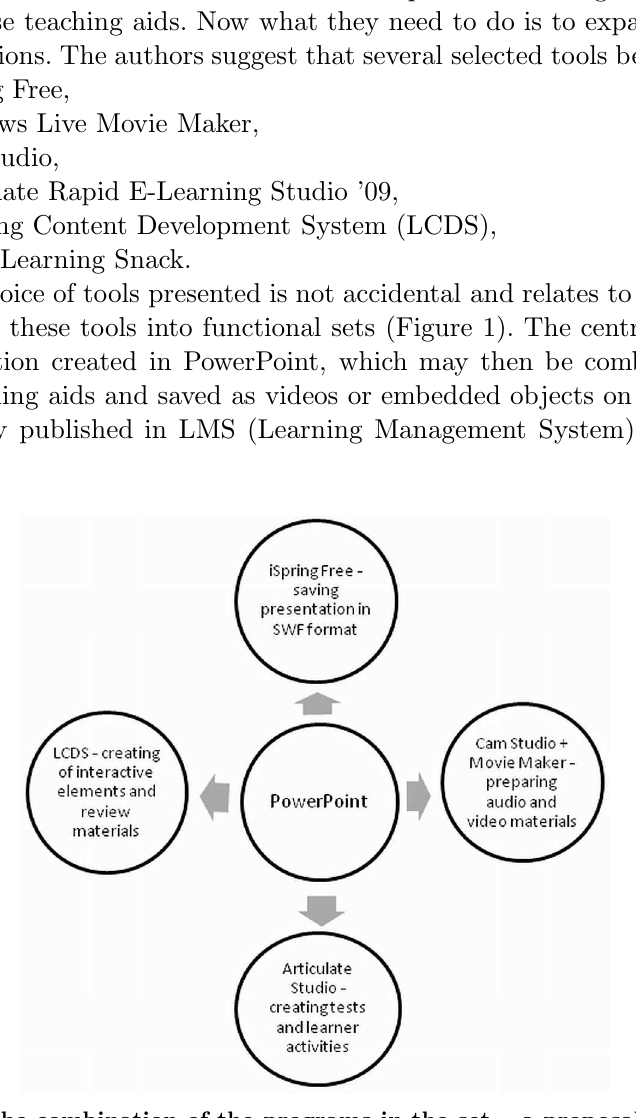
Figure 1. The combination of the programs in the set – a proposal of the authors